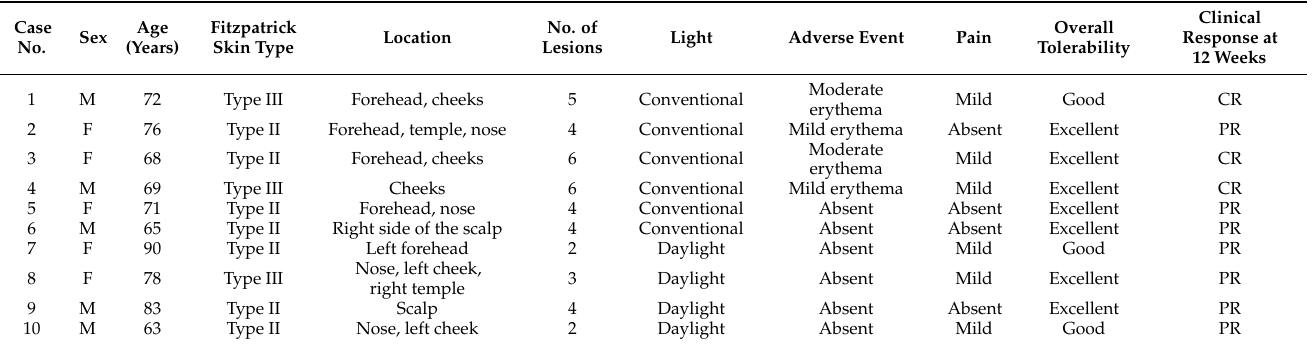
Table 2. Demographic data and clinical outcomes of our patients with actinic keratosis (AK) treated with a single application of 5-aminolevulinic acid